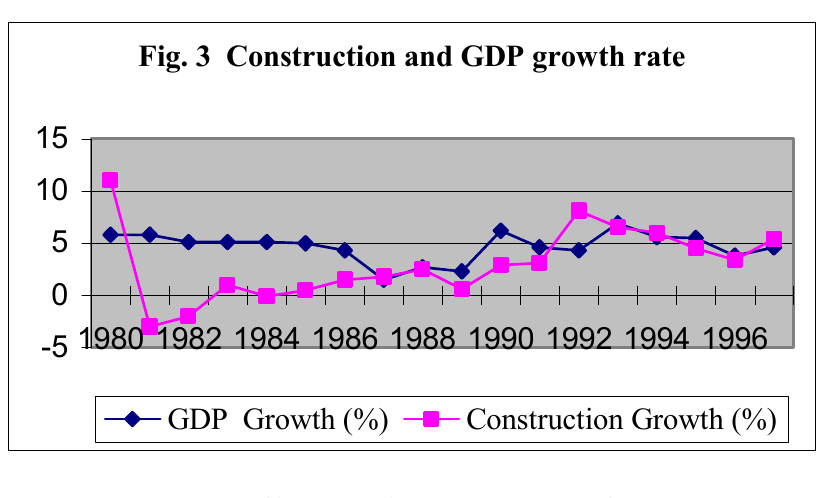
Fig.4 Trend of Construction